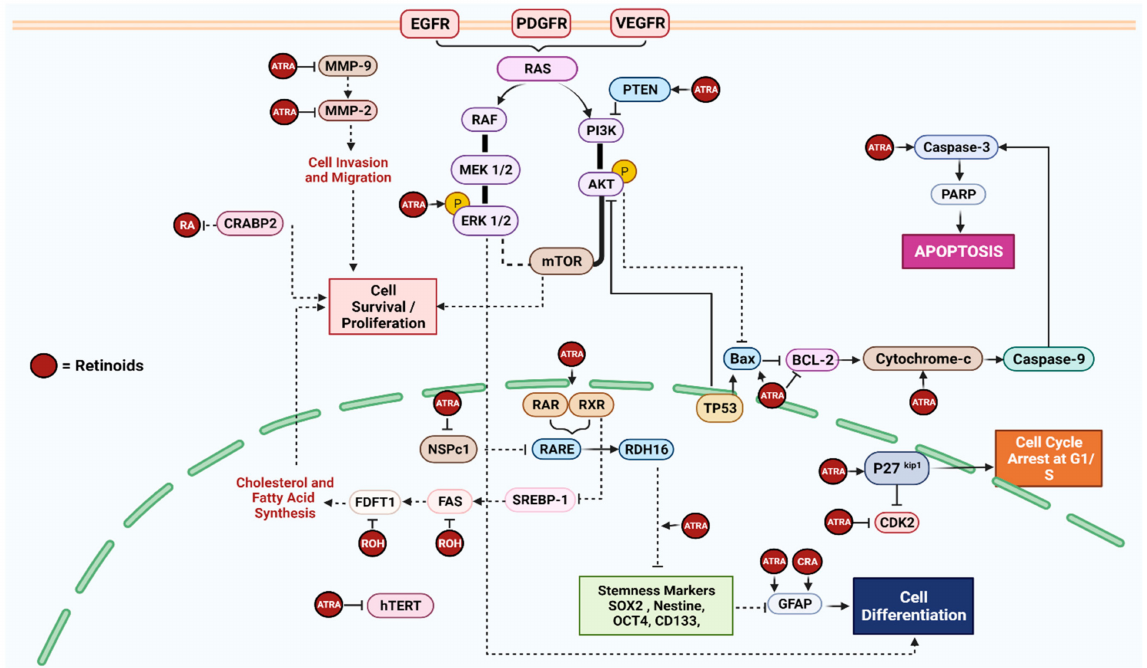
Figure 2. Illustration of the cellular pathways in GBM where the retinoids of vitamin A interact, identified from the systematic literature review of vitamin A [18–24]. (Created with